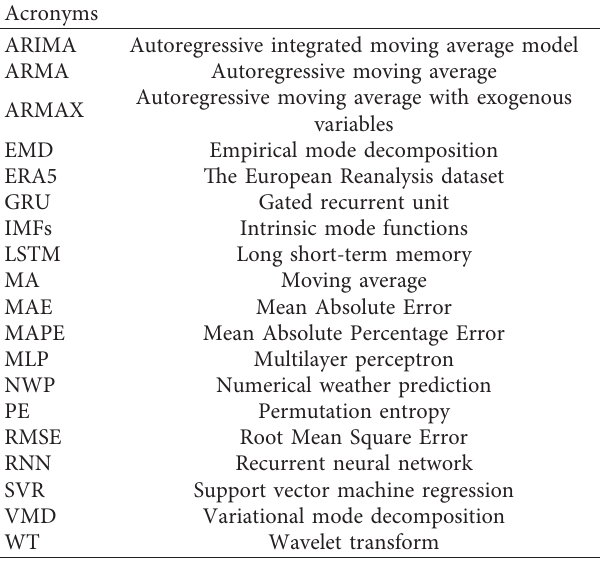
Table 1: Acronyms used in the article.